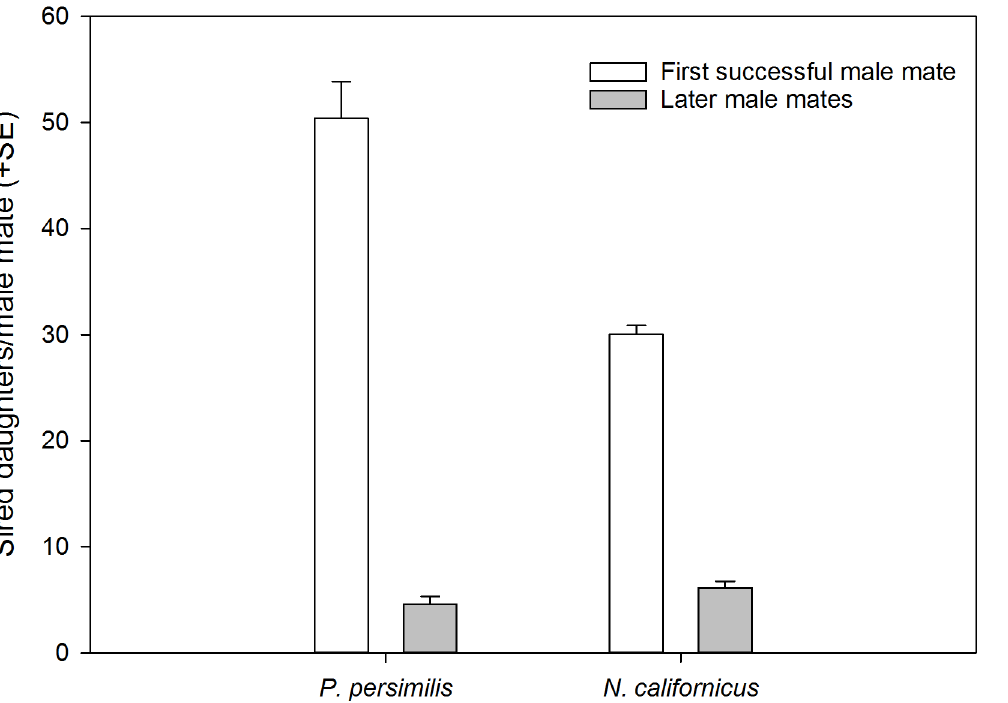
Fig 6. Paternity success index. Estimated number of sired daughters of first successful and later male mates of P . persimilis (N = 20) and N . californicus (N = 19). Results of GEE: species (Wald ӽ 2 = 17.906, P < 0.001), male mate (Wald ӽ 2 = 330.195, P < 0.001), species * male mate (Wald ӽ 2 = 32.741, P <